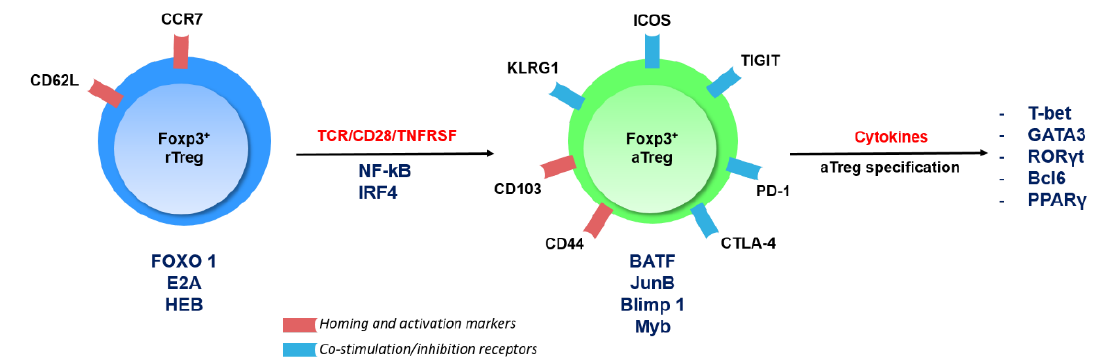
Figure 1. Activation steps of regulatory T cells (Treg cells) and their transcriptional regulation. The figure depicts the main transcription factors involved in the programming and maintenance of Treg